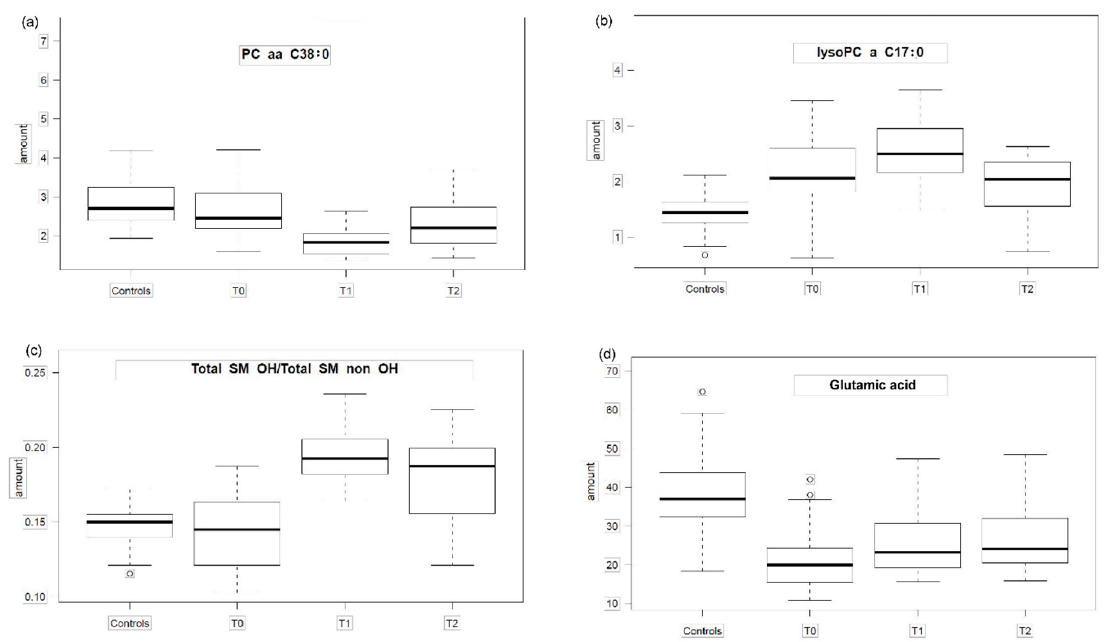
Figure 2. The four main patterns of group means of analyte concentrations. The box plots show concentrations of analytes/metabolites (or metabolite ratios) in HC (healthy controls), T 0 , T 1 and T 2 to illustrate 4 different patterns presented in Table 3. ( a ) pattern group 2 (PC aa C38:0: Kruskal-Wallis test p = 2.1 × 10 − 8 , Table S1); ( b ) pattern group 3 (lysoPC a C17:0 Kruskal-Wallis test p = 1.9 × 10 − 8 ); ( c ) pattern group 1 (total SMOH/total SM non OH Kruskal-Wallis test p = 1.0 × 10 − 10 ); ( d ) pattern group 4 (Glutamic acid Kruskal Wallis test p = 3.2 × 10 − 7 ); T 0 = admission, T 1 = half of target weight, T 2 = long-term weight gain close to target weight. The box and whiskers plot show median (50th percentile) as line, interquartile range (IQR: 25th to the 75th percentile) as box, and minimum and maximum (for minimum and maximum values within Q3 + 1.5*IQR and Q1—1.5*IQR) or Q3 + 1.5*IQR and Q1-1.5*IQR (if minimum and maximum values fell outside Q3 + 1.5*IQR and Q1—1.5*IQR; in that case outlying values are denoted by a